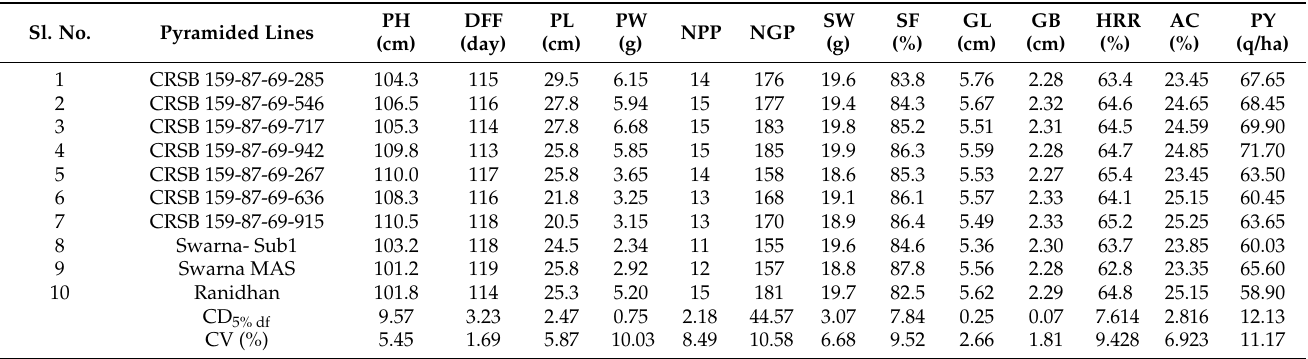
Figure 8. Genotype-trait biplot generated for the pyramided and parental lines using different traits: PH, plant height; NGP, number of grains/panicle; DFF, days to 50% flowering; NPP, number of panicles/plant; PL, panicle length; PW, panicle weight; SF, spikelet fertility; SW, 1000-seed weight; GL, grain length; GB, grain breadth; PY, plot yield. Table 4. Evaluation of pyramided lines for various yield and agro-morphologic traits in BC 3 F 4 and BC 3 F 5 generations.